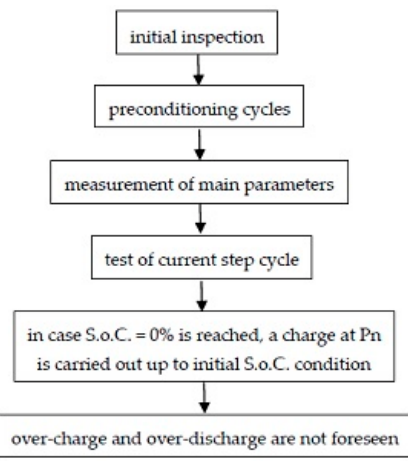
Figure 6. Flow-chart of the procedure foreseen for a ‘step current’ cycle.